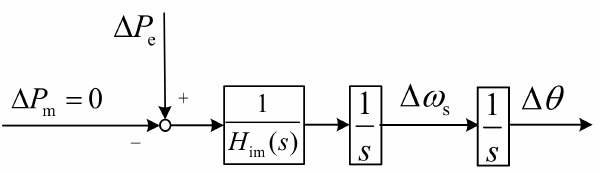
Figure 5. Phase motion equation of potential after transient reactance with equivalent inertia.